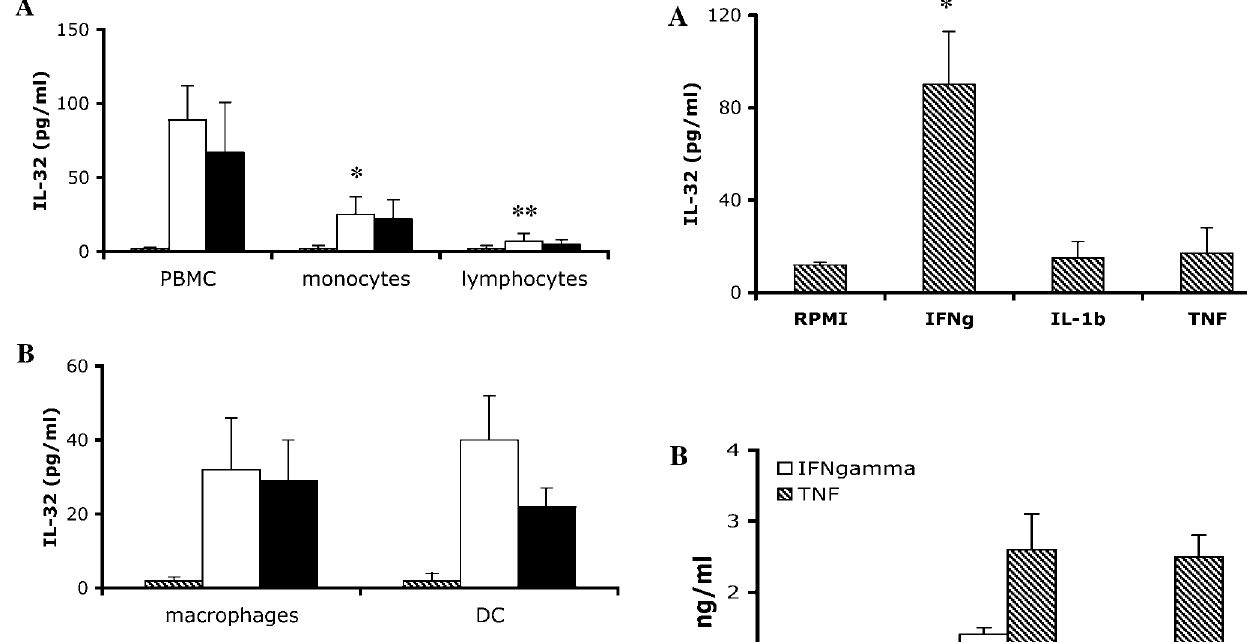
Figure 4. IL-32 Production by Monocytes, Macrophages, and DCs (A) PBMCs were incubated for 2 h at 37 8 C in 96-well plates, and non- adherent lymphocytes were transferred to a different well. The total PBMCs, the adherent monocytes, or the non-adherent lymphocytes were stimulated with RPMI (hatched bars), M. tuberculosis (open bars), or M. bovis BCG (solid bars) for an additional 24 h. After 24 h, IL-32 concentrations were measured. (B) Adherent monocytes were incubated for 5 d with RPMI and 20% human serum for macrophage differentiation, or a combination of 50 ng/ ml GM-CSF and 20 ng/ml IL-4 for DC differentiation. The macrophages and DCs were thereafter stimulated for an additional 24 h with RPMI (hatched bars), M. tuberculosis (open bars), or M. bovis BCG (solid bars). IL- 32 concentration was measured by ECL. Data are presented as means 6 SEM ( n ¼ 8); *, p , 0.05; **, p , 0.01. DOI: 10.1371/journal.pmed.0030277.g004